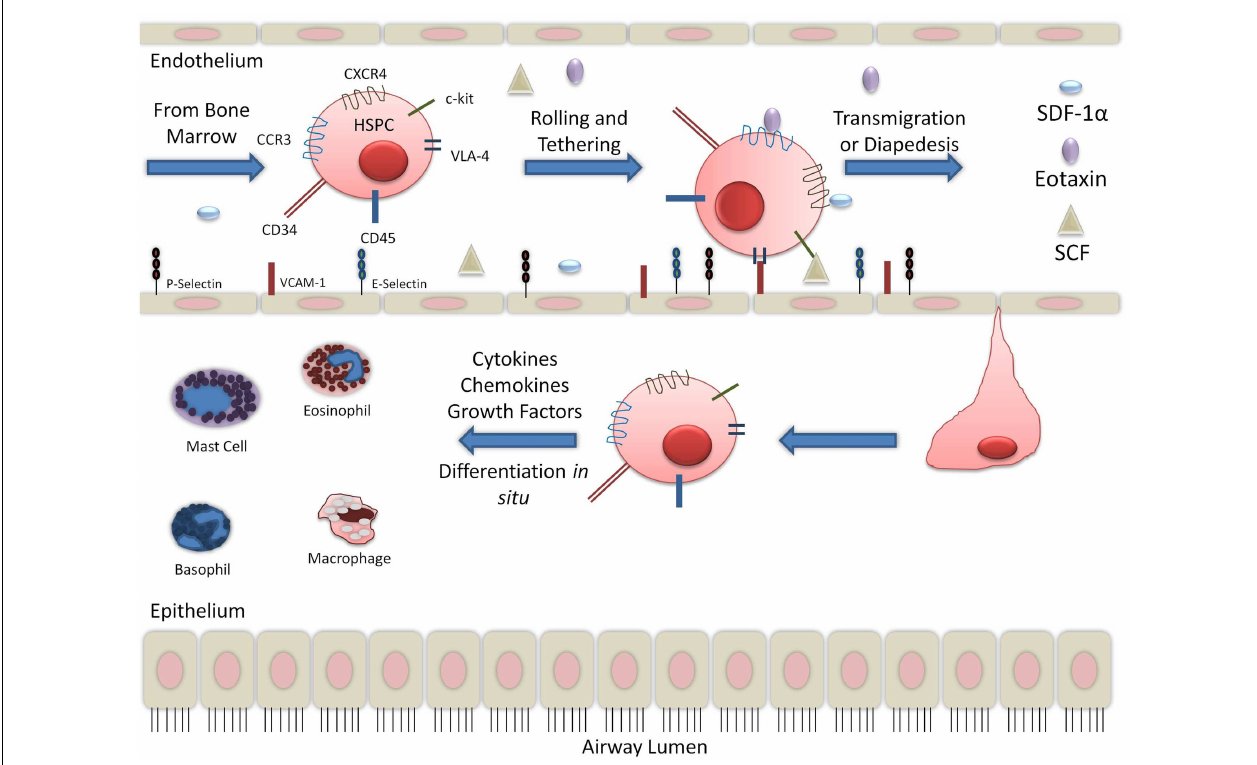
FIGURE 1 | Migration of hematopoietic progenitor cells into lung tissue: while the migration and diapedesis of hematopoietic stem/progenitor cells are not completely understood, chemoattractants such as eotaxin, SCF, and SDF-1 α can initiate HSPC migration to the site of inflammation in the lung tissue